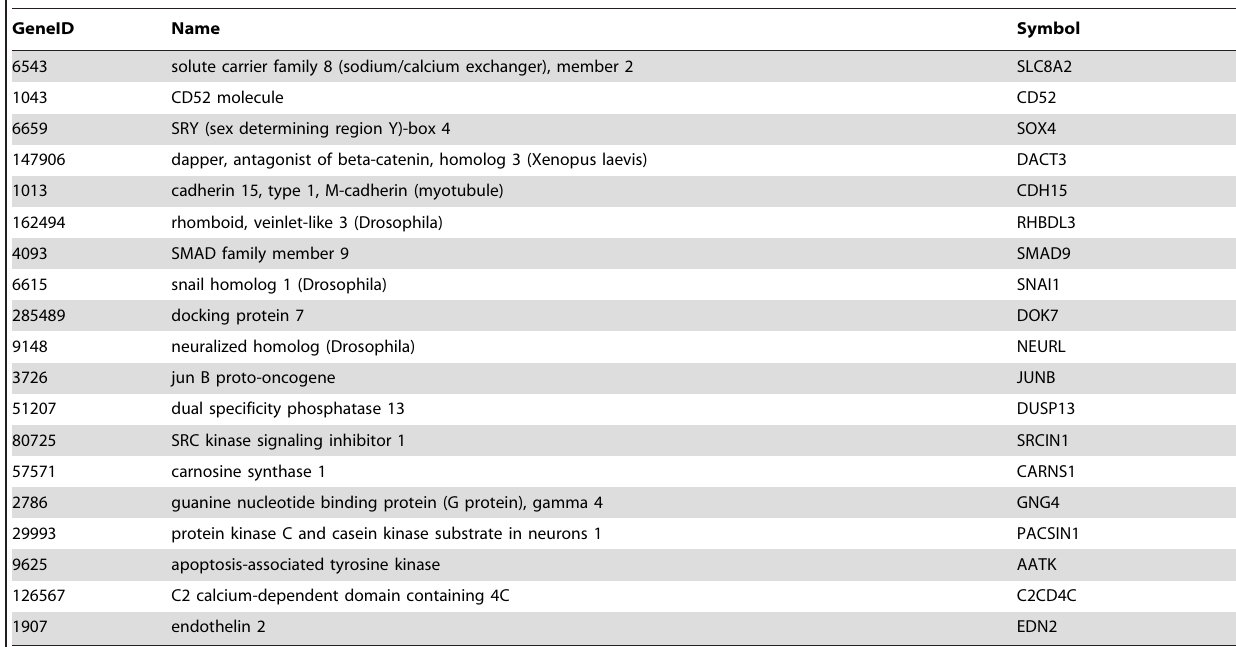
Table 1. Genes regulated with ATF-126 and Maspin cDNA.